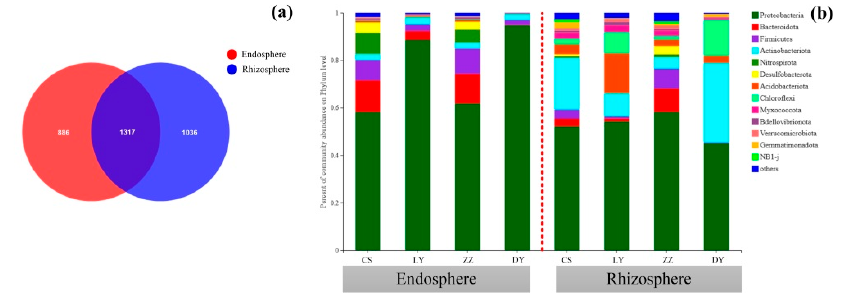
Figure 3. ( a ) Venn diagram of exclusive and shared bacterial OTUs (at the 3% evolutionary dis- tance) between the endosphere and rhizosphere of C . communis . ( b ) Bacterial community composi- tion at the phylum level in the endosphere and rhizosphere of C . communis in four different sam- pling